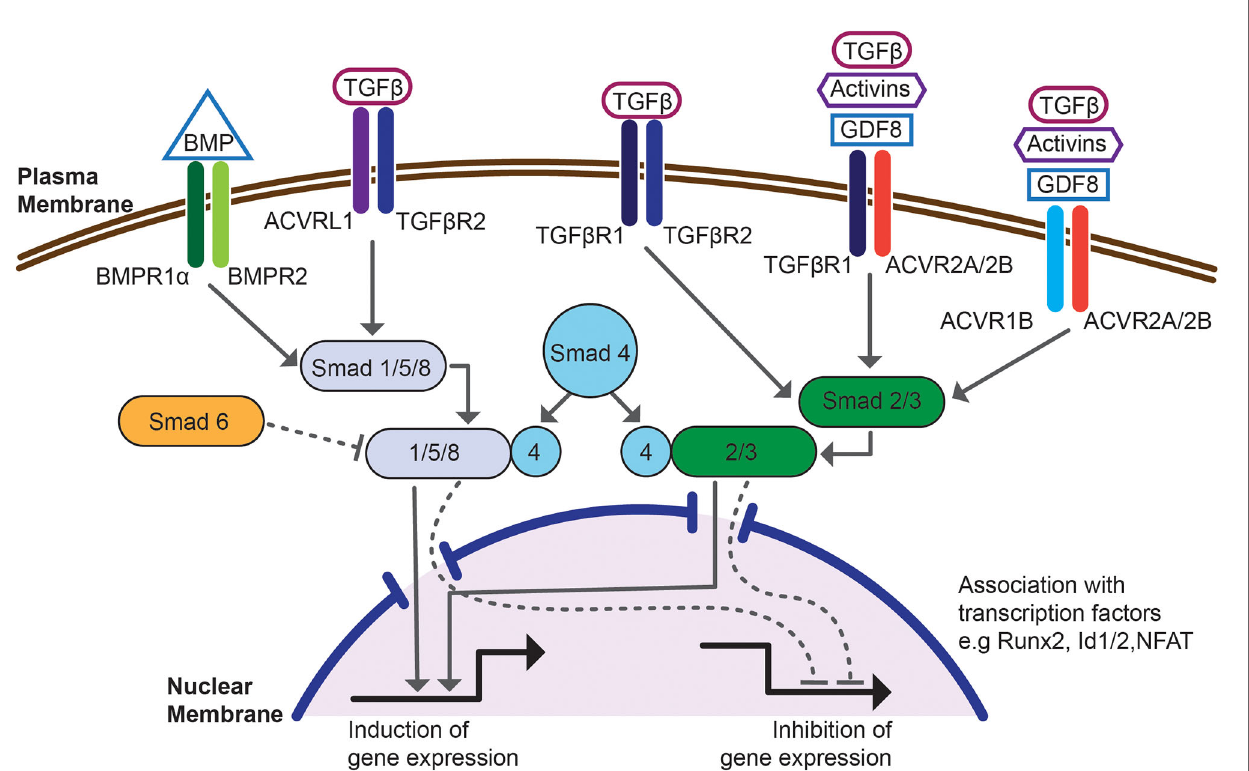
FIGURE 1 | Schematic overview of the canonical, SMAD-dependent BMP and TGF- b signaling pathway. Signaling is initiated by binding to a heteromeric complex of type I receptors, e.g. BMPR1 a , TGF- b R1, ACVRL1 or ACVR1, associated with type II receptors, e.g. BMPR2, TGF- b R2, ACVR2A/2B. Intracellular, BMP or TGF- b responsive transcription factors, Smads become phosphorylated and associate with co-Smad4 and translocate into nucleus. This signaling pathway is controlled by inhibitory Smad6. Once in the nucleus Smad complexes associate with transcription factors e.g. Runx2, Id1/2 or NFAT, bind regulatory regions of Smad dependent genes and regulate transcription. The fi gure shows interdependence of BMP and TGF- b signaling at the level of receptor binding and Smad